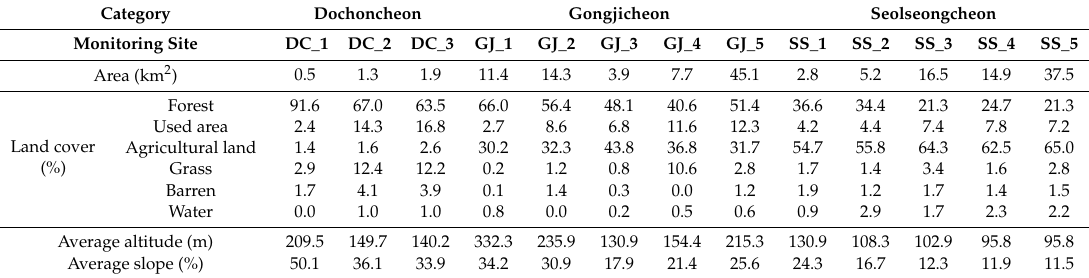
Table 1. Monitoring sites and land cover for each